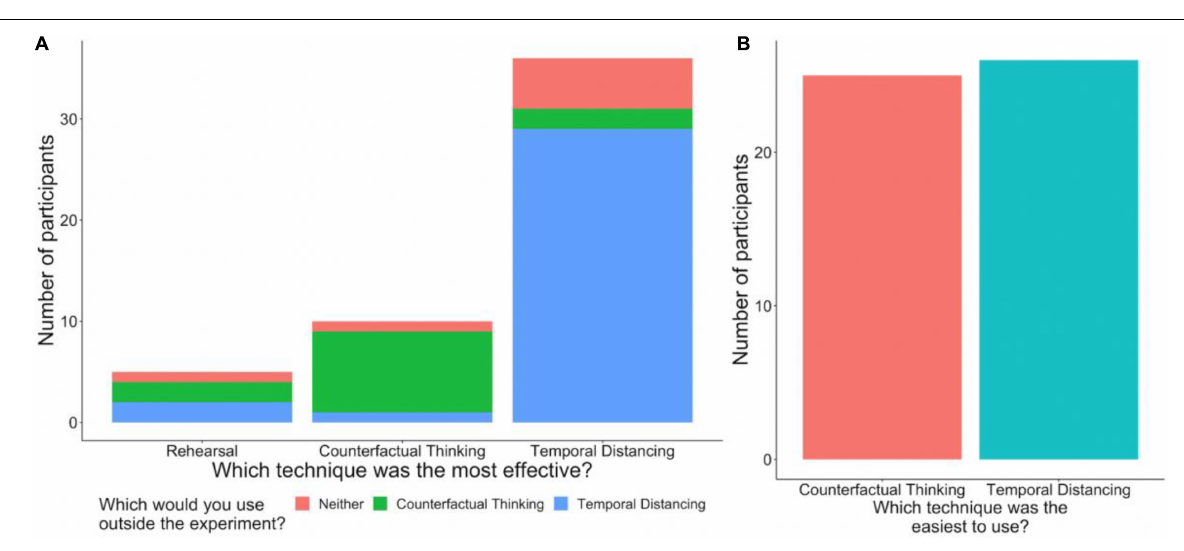
FIGURE 4 | Counts of people choosing each technique for post-experiment questions. (A) The number of participants that selected each technique as the most effective, color coded by which technique that participant said they would use in their daily lives. For the most part, individuals’ answers for the two questions were the same. (B) The number of participants that chose each technique for which technique was easiest to